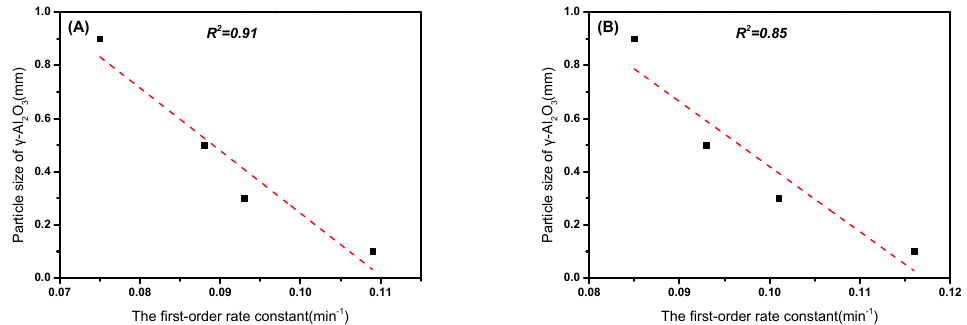
Figure 8. The linear correlation of the first-order rate constant and the particle size of γ -Al 2 O 3 (sample A ( A ), sample B ( B )).